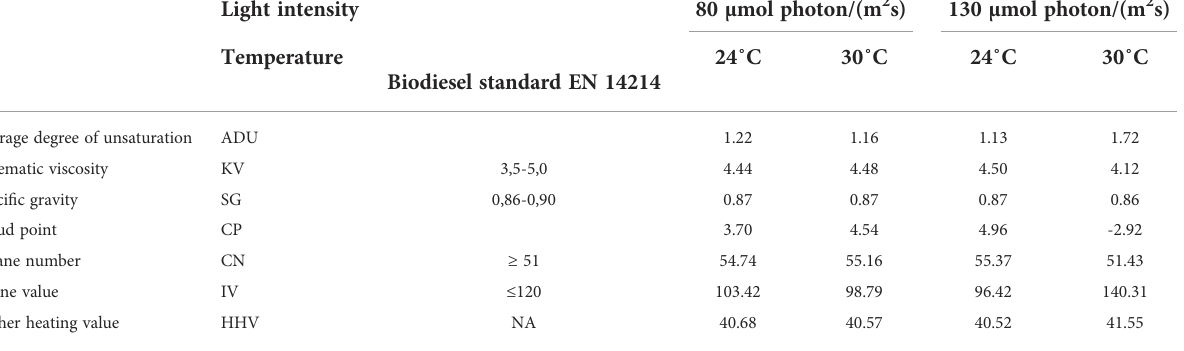
TABLE 4 Biodiesel properties calculated from the FAME pro fi le of P. wilhelmii grown under 24°C and 30°C; c(DIN) = 1.3 mmol/L; light levels 130 µmol phot/(m 2 s) and 80 µmol phot/(m 2 s), and diurnal (12:12) light